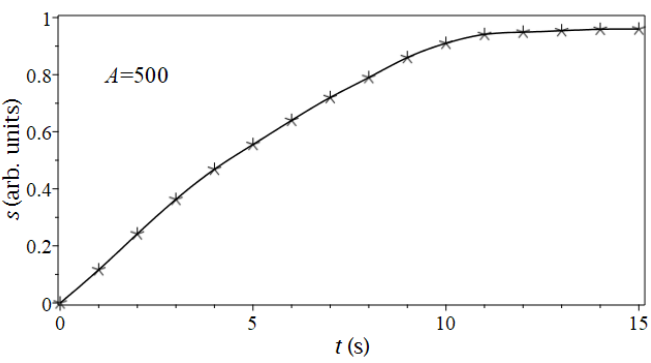
Figure 7. Kinetics of the relative order parameter with 10 s mean reorientation time.